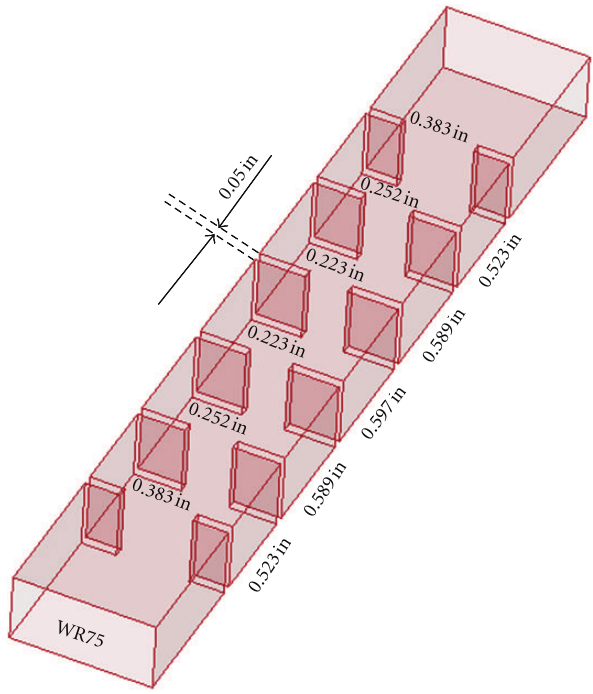
Figure 11: Configuration of waveguide filter with 5 open cavities.